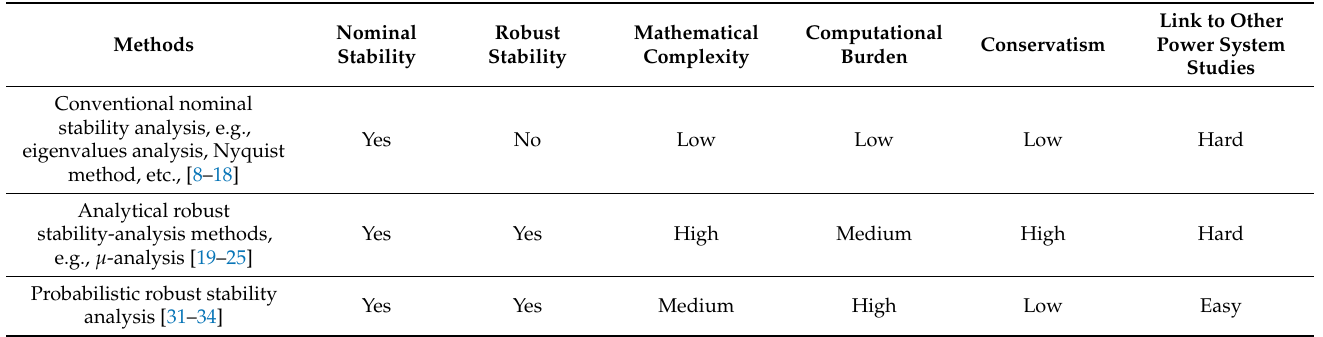
Table 1. State-of-the-art nominal and robust stability-analysis